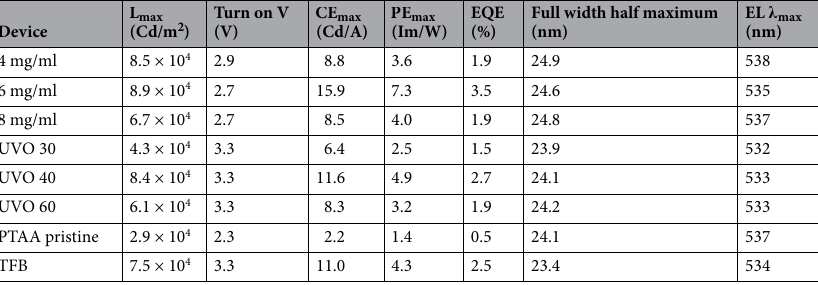
Table 1. Device performance of the QLEDs on the ITO glass substrates with TFB and various PTAA HTLs.